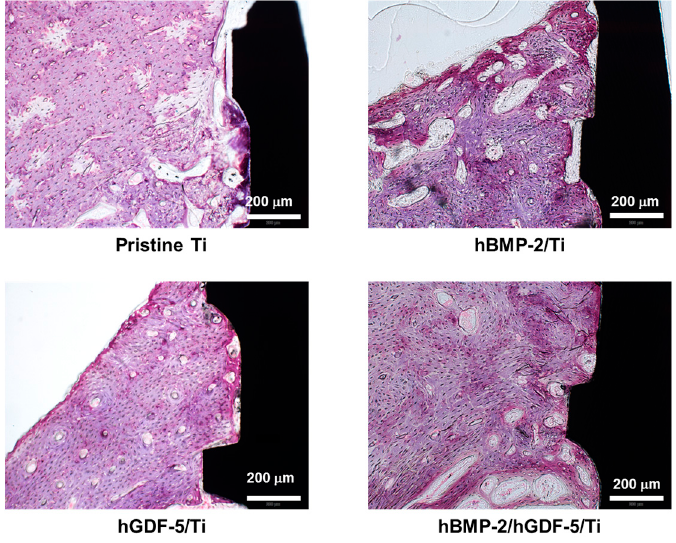
Figure 9. H and E stained images of the surrounding tissue around the pristine Ti, hBMP-2/Ti, hGDF-5/Ti, and hBMP-2/hGDF-5/Ti samples after implantation into femur heads for four weeks. The purple areas indicate the cortical bone of femur area. The white scale bar indicates 200 μ m.